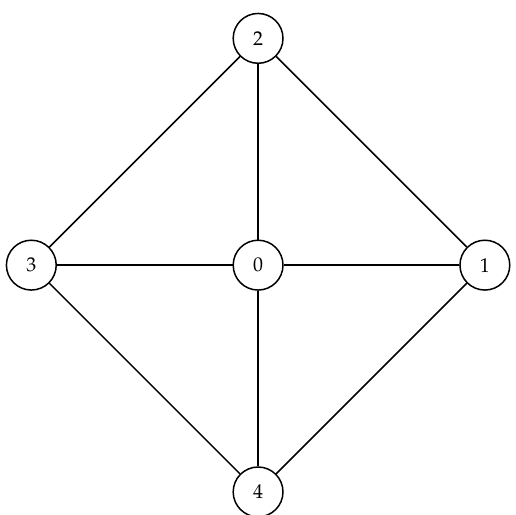
Figure 2. The above graph depicts an example of a tour consisting of four nodes plus the depot (node 0).